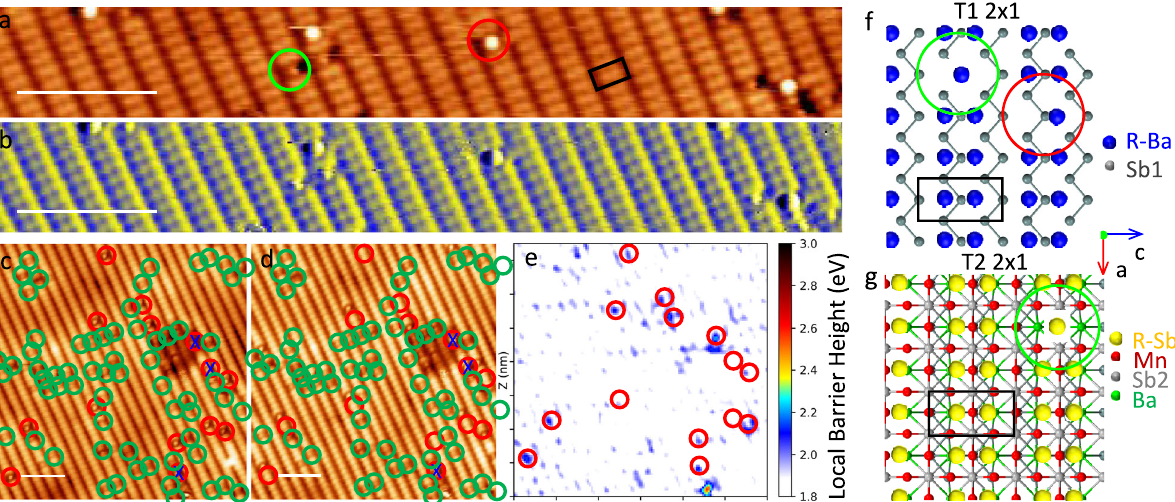
Fig. 3 Defects in BaMnSn 2 . a , b , STM and current images (set point: − 2 V, 50 pA) of an area show both type-A defect (green circle) and type-B (red circle) defects. A 2 × 1 unit cell is marked in a black rectangle. The scale bars represent 4 nm. c , d Two sequential STM images collected at the same location with 12 hours separation (set point: − 1 V, 100 pA). All defects are marked by green (type-A) and red (type-B) circles, there are three of the red circles marked with blue crosses. See text for details. The scale bars represent 3.5 nm. e Local barrier height image from the same area as ( c and d ). f , g 2 × 1 reconstruction models (black rectangles) for T1 and T2 with both type-A (green circle) and type-B (red circle) defects. To differentiate from the truncated surface, the reconstructed atoms are draw in blue (R-Ba) and yellow (R-Sb2), respectively.